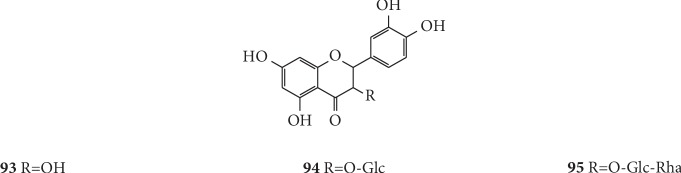
Structures of flavonoids in G. littoralis.